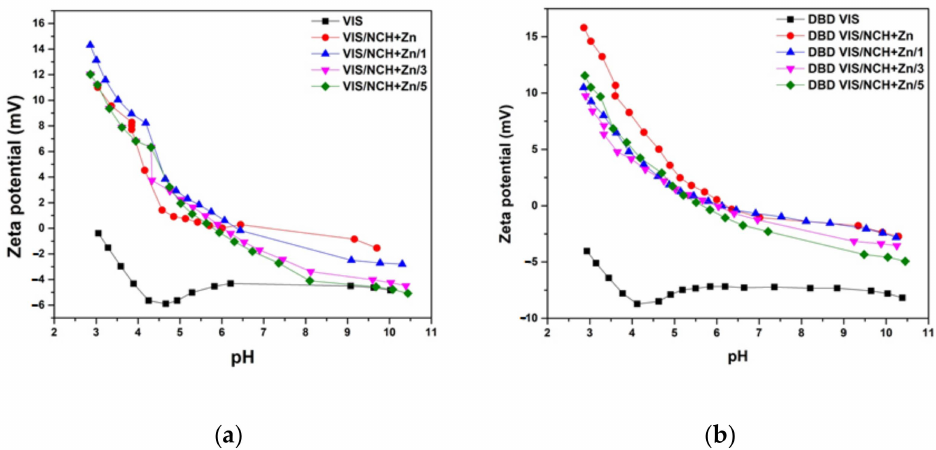
Figure 7. Zeta potentials of unmodified ( a ) and DBD-modified ( b ) viscose fabrics before and after functionalization with NCH+Zn. Part of results previously published in